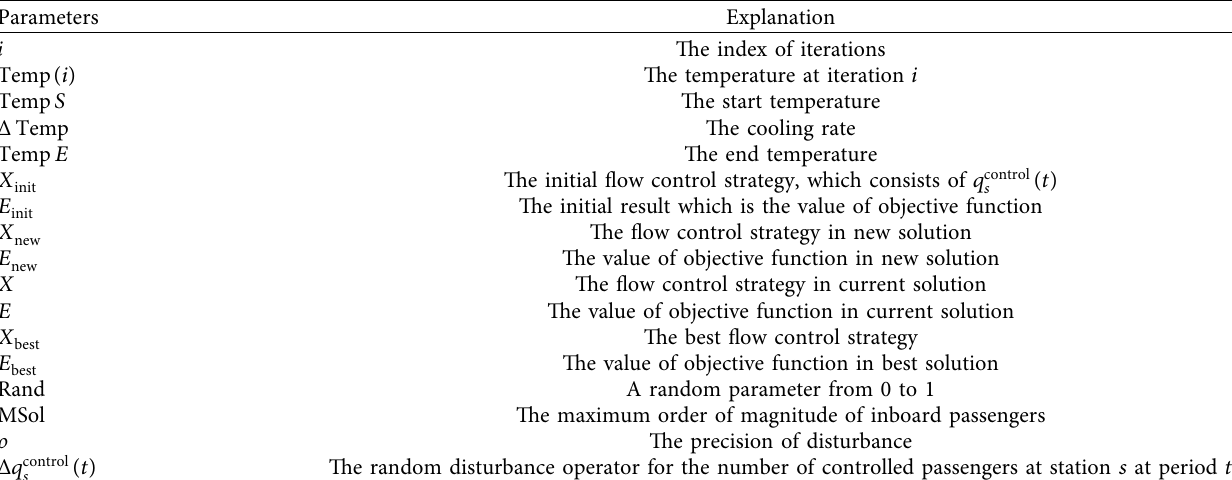
Table 4: Explanation of parameters in the ISA algorithm.